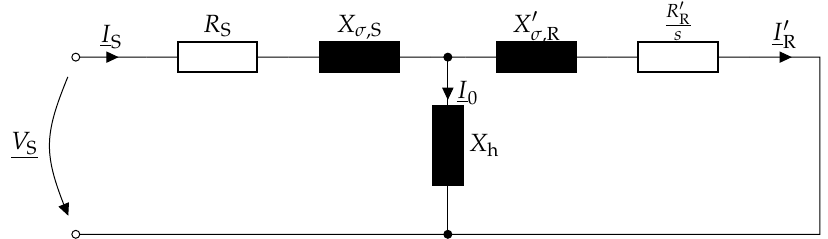
Figure 2. Representation of the single-phase ECD of the IM with a squirrel cage